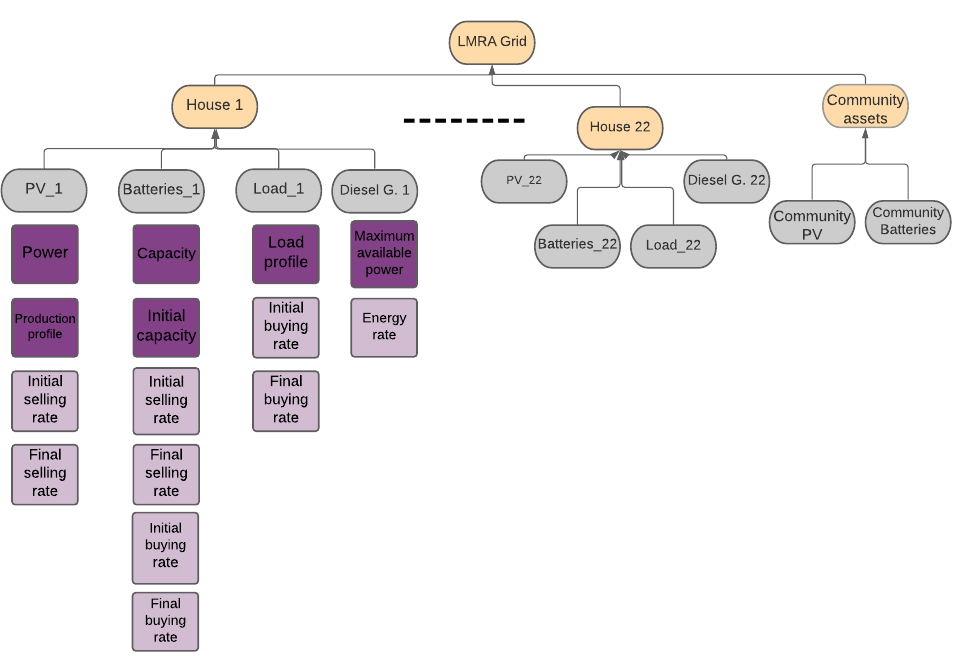
Figure 5. LEM modeling. The market players are marked in yellow (houses and market maker), with gray marking the assets (PVs, storage (batteries), loads, and diesel gen.), with dark purple marking the power properties of the assets and light purple marking the market properties of the assets.